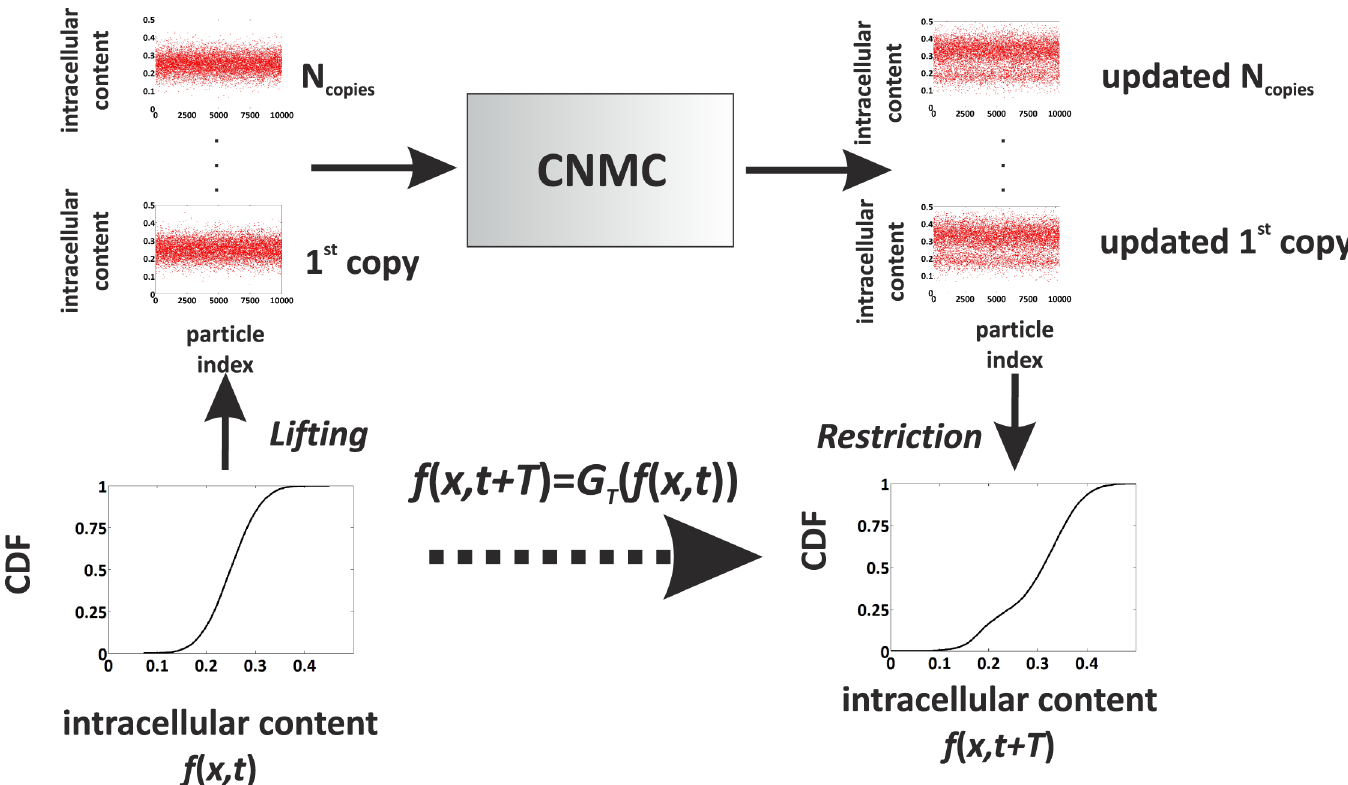
Fig 3. The coarse time-stepper. A schematic of the coarse time-stepper for the model of an isogenic cell population simulated by the CNMC